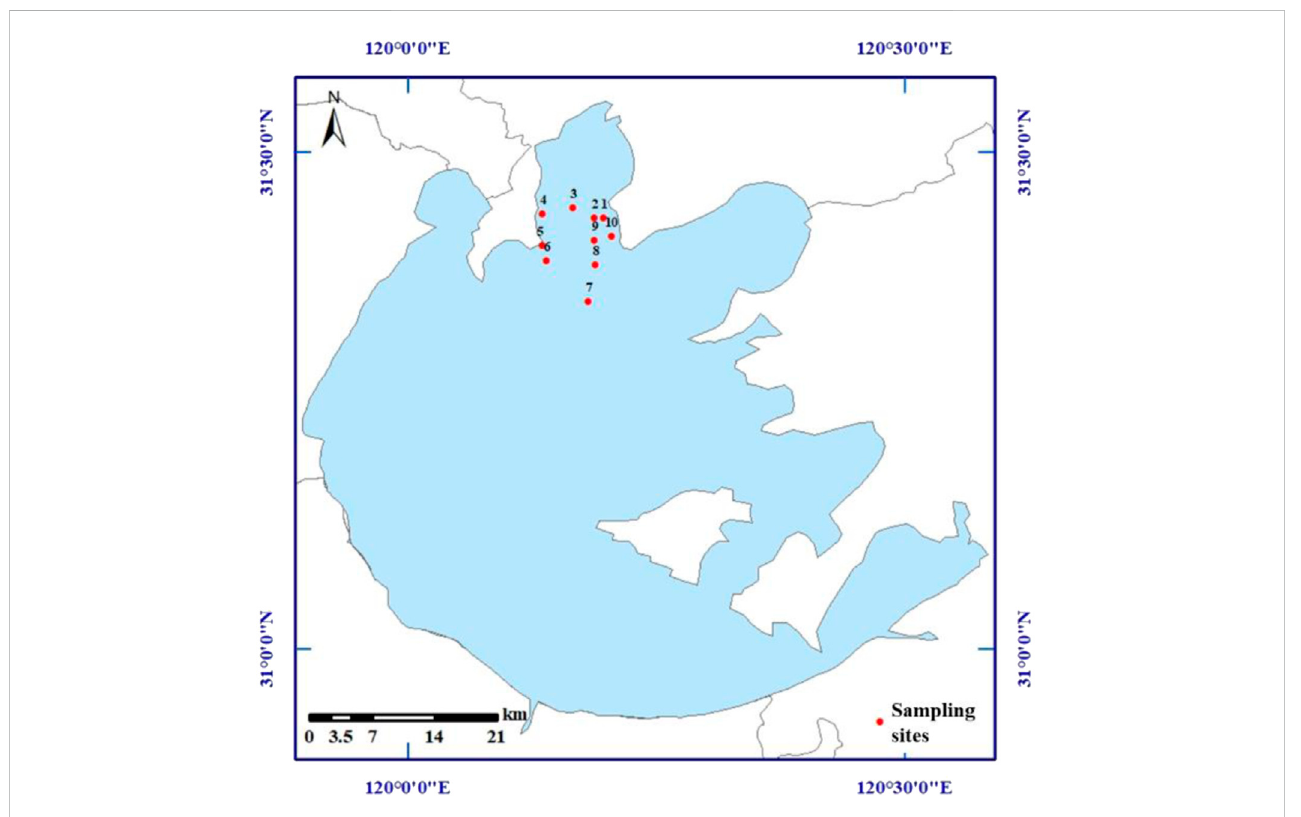
FIGURE 1 Location of sampling sites in Meiliang bay of Taihu Lake in